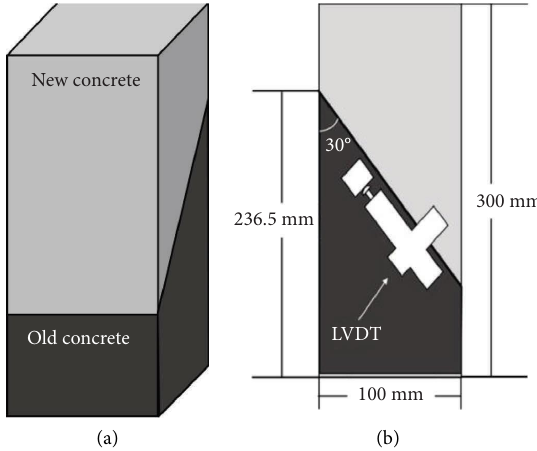
Figure 2: Detail of the slant shear specimen. (a) Isometric view. (b) Front view.